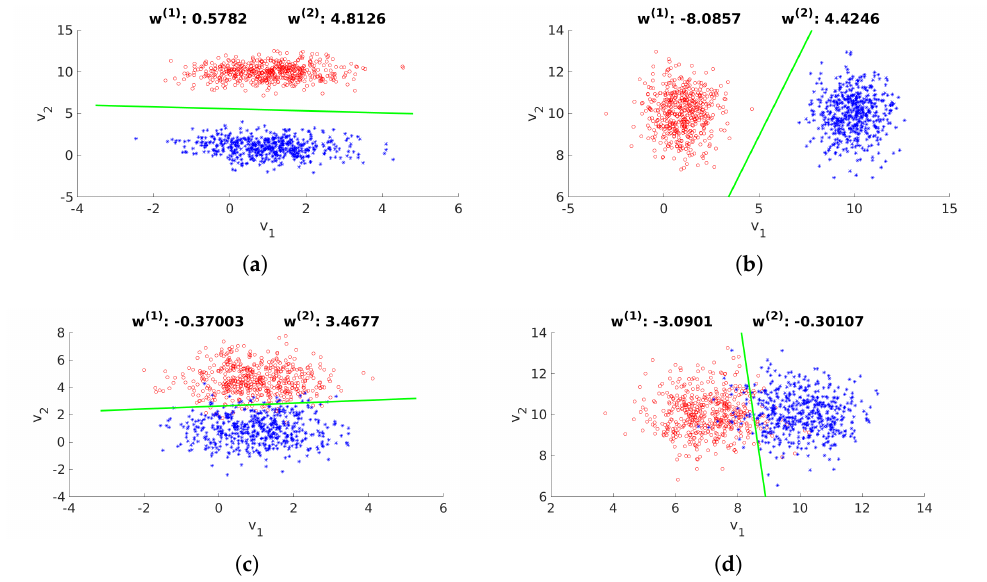
Figure 2. A 2D binary classification illustration using synthetic data, in variables v 1 and v 2 . The hyperplane parameters w ( 1 ) , w ( 2 ) , and β (the latter not shown here) are calculated by a single- layer neural network, whose result is depicted by a green line segment. The magnitude of the neural networks (or the hyperplane parameters) indicate the relevance of its correspondent feature. ( a ) Two linearly separable classes. Clearly, attribute v 2 provides good separation between the clusters, which is corroborated by w ( 2 ) > w ( 1 ) . ( b ) A similar situation as in ( a ) occurs here, but this time v 1 provides the separation between the clusters, and w ( 1 ) > w ( 2 ) . In ( c , d ) it is possible to draw the same conclusion, even when the clusters